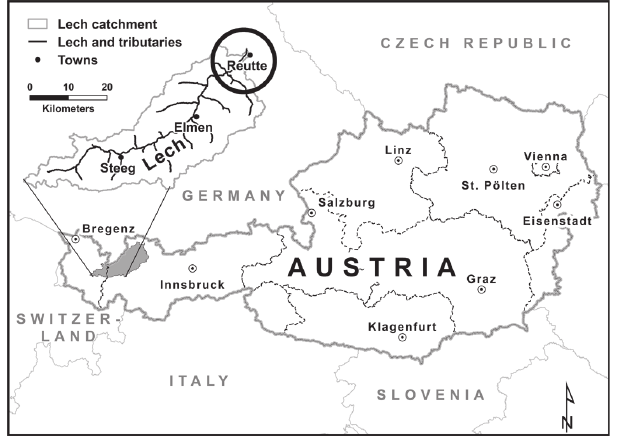
Fig. 1. Geographical overview of the study area in